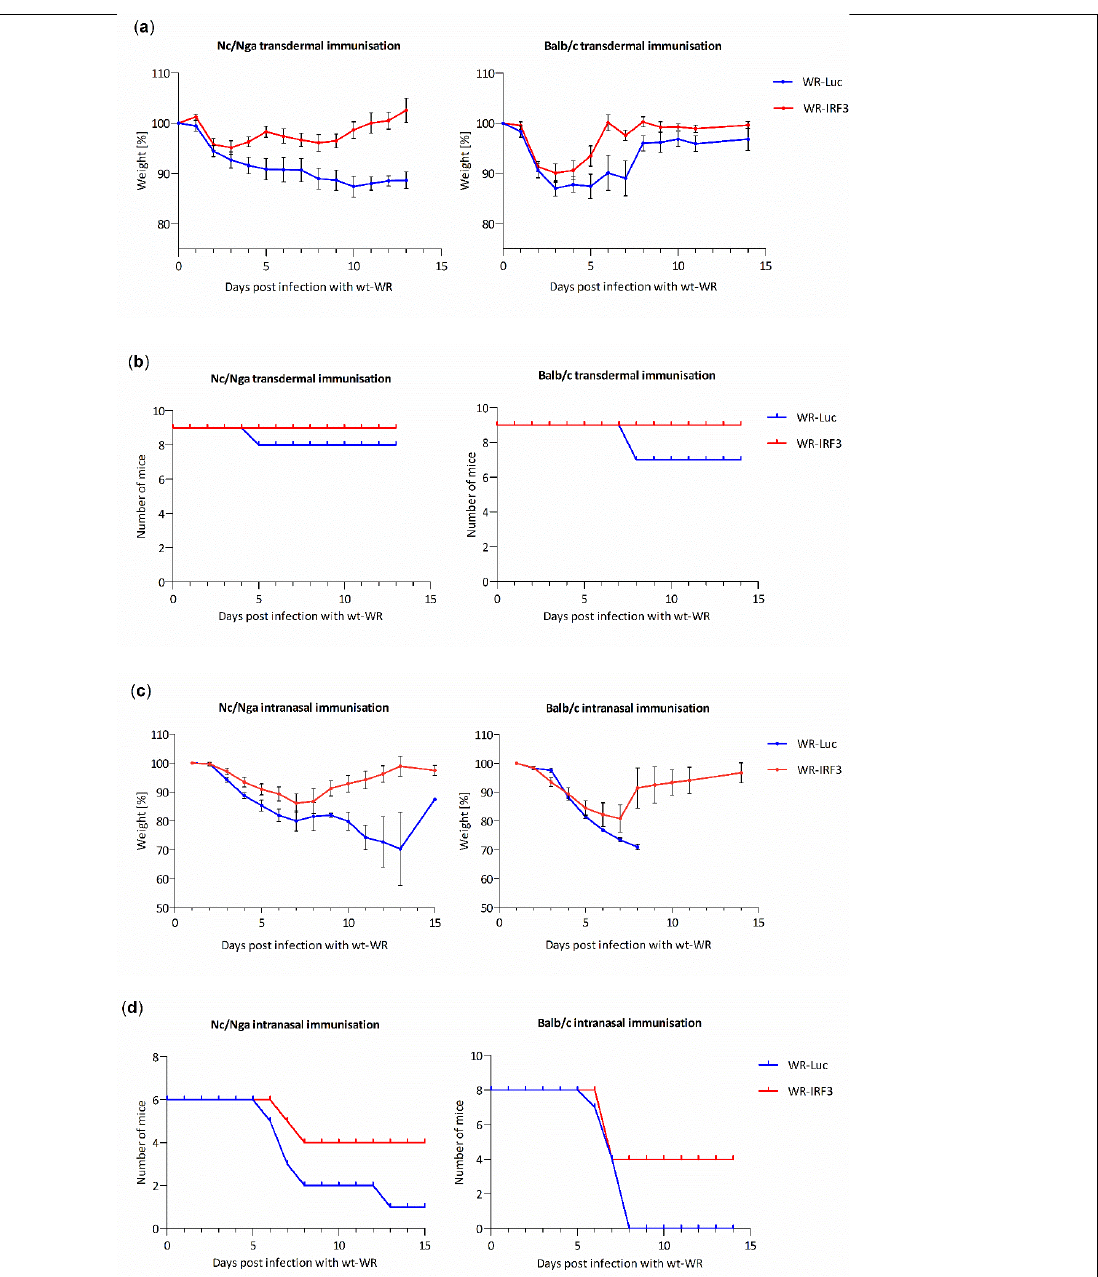
Figure 6. Immunization with WR-IRF3 induces better protective immunity against a lethal chal- lenge with wt-WR. Nc/Nga and Balb/c mice were immunized t.d. (10 4 PFU/mouse) or i.n. (10 3 PFU/mouse) with purified WR-Luc or WR-IRF3. At 24 days later (day 0 in the graphs), they were infected i.n. with a lethal dose of wt-WR (10 5 PFU/mouse). Changes in body weight and survival of mice immunized ( a , b ) t.d. and ( c , d ) i.n. are presented. ( a , c ) Graphs represent means +/ − S.E.M. The survival of mice of both strains immunized i.n. with WR-IRF3 ( d ) was statistically significant at p < 0.1 (log-rank Mantel–Cox test). Statistically significantly higher body weight of mice immunized with WR-IRF3 (one-tailed unpaired Student’s t -test): ( a ) Nc/Nga t.d. immunization, 1 and 2 days p.i., p < 0.1; 4–13 days p.i., p < 0.05; Balb/c t.d. immunization, 9–10 days p.i., p < 0.1; 5–8, 11 days p.i., p < 0.05; ( c ) Nc/Nga i.n. immunization, 2–5, 8–12 days p.i., p < 0.05; Balb/c i.n. immunization, 6 days p.i., p < 0.1; 2 and 7 days p.i., p < 0.05. WR-Luc, mice immunized with VACV expressing luciferase; WR-IRF3, mice immunized with VACV expressing Mu